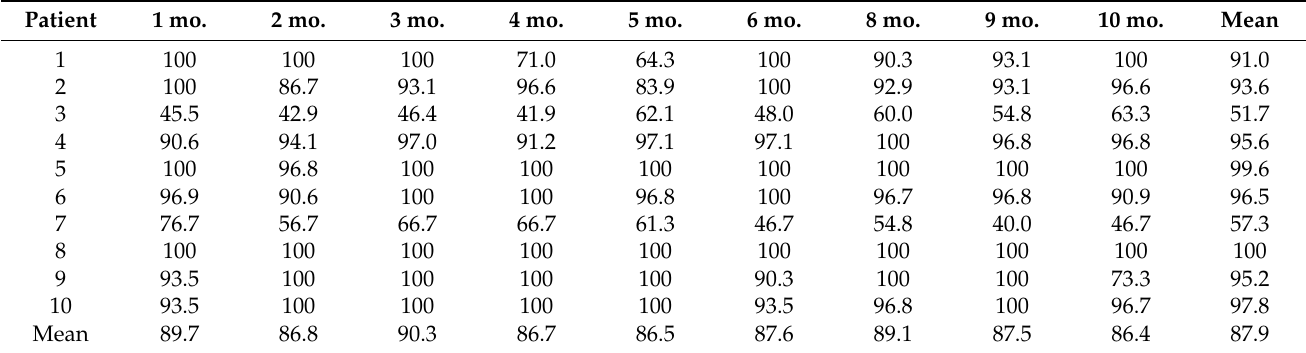
Table 4. Exercise implementation rate